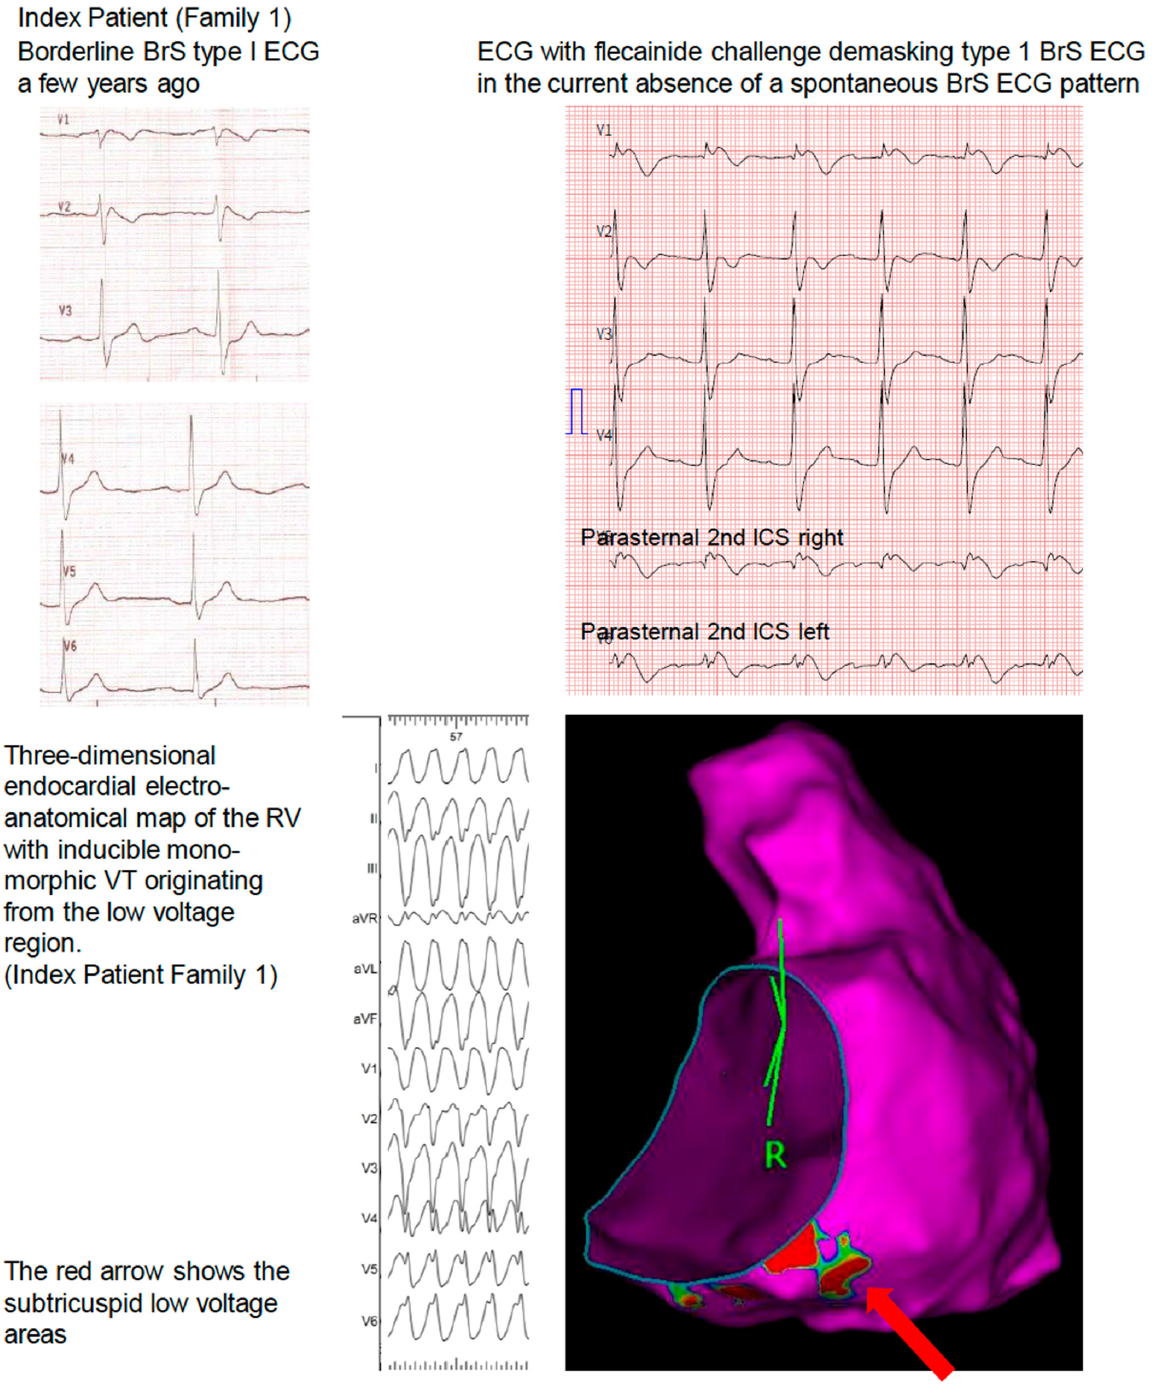
(Figure 1). A flecainide challenge test, in the current absence of a spontaneous BrS ECG pat- tern, revealed drug-induced Brugada type 1 ECG changes. An invasive electrophysiological evaluation including three-dimensional endocardial electroanatomical mapping showed RV subtricuspid inferior low-voltage areas. Repetitive, sustained monomorphic VT could be induced from this region during isoprenaline provocation. A cardiac 18-FDG-PET-CT excluded cardiac sarcoidosis or myocarditis. The family history was negative for sudden cardiac death, unexplained syncope, drowning, near drowning, or single person motor vehicle accidents over four generations.